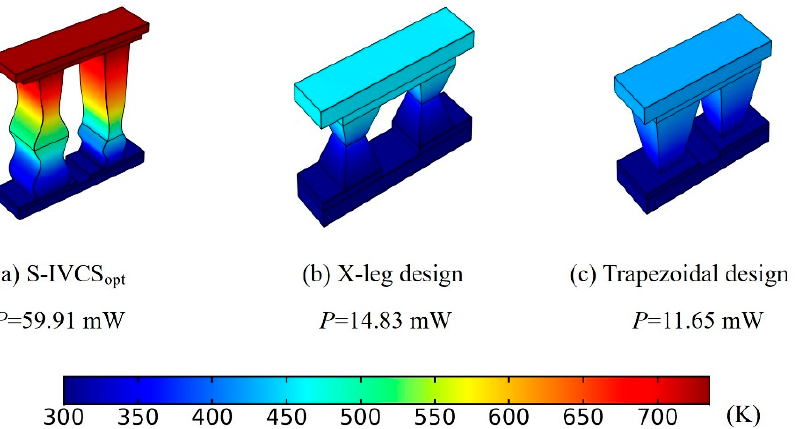
Figure 16. Performance comparison of the proposed design with other studies: ( a ) the present design; ( b ) the X-leg design; ( c ) the trapezoidal design.